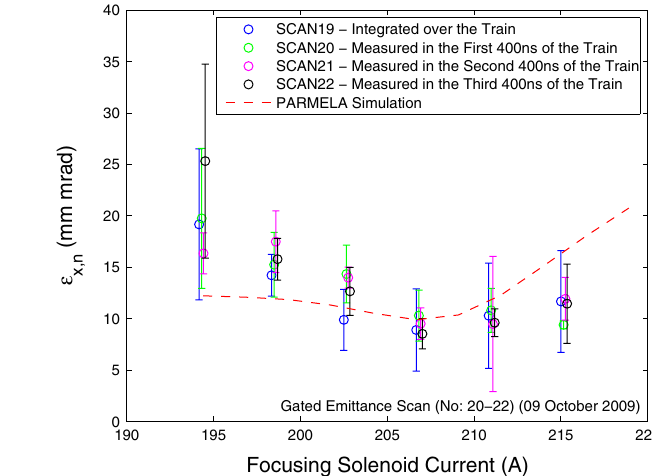
FIG. 11. Emittance scan, with a beam of 1.6 nC, 4.8 MeV, along the bunch train with the steps of 400 ns.